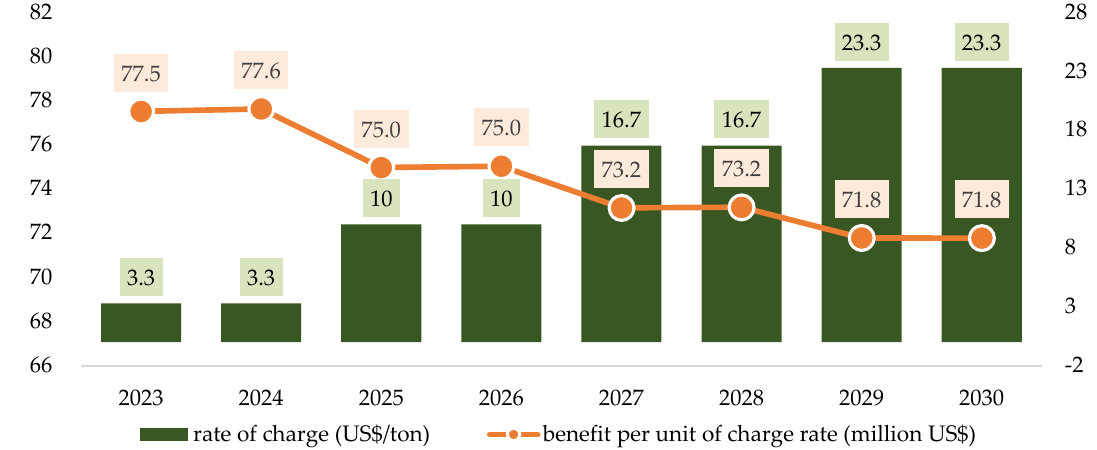
Figure 8. The average benefit for every unit fee rate under scenario 2 in 2023–2030.